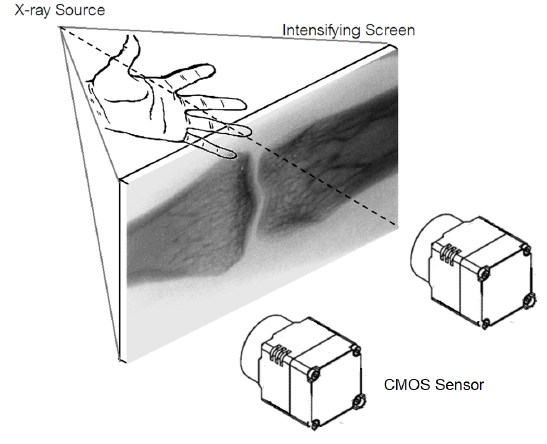
Figure 1. CMOS-sensor X-ray Detector.